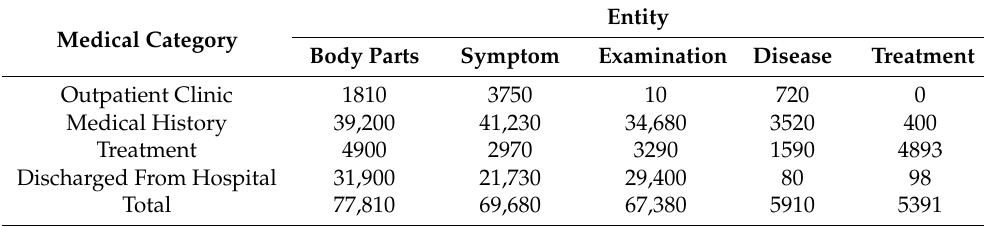
Table 1. Statistical results of various medical entities in electronic medical records.